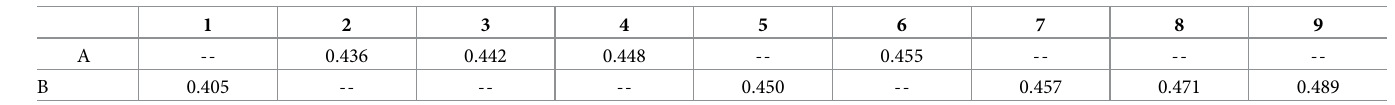
Table 9. Rank sum test sample